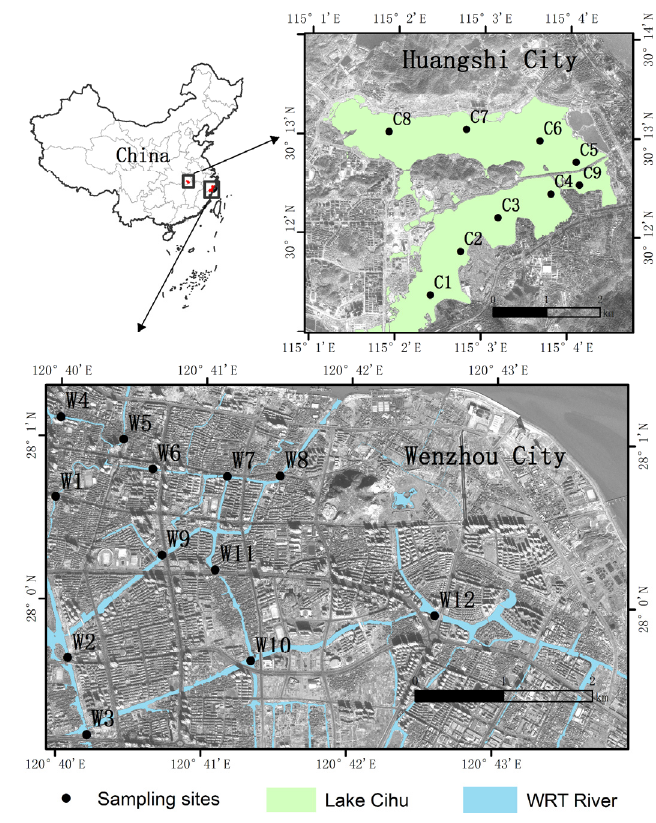
Figure 1. Location of study areas and sampling